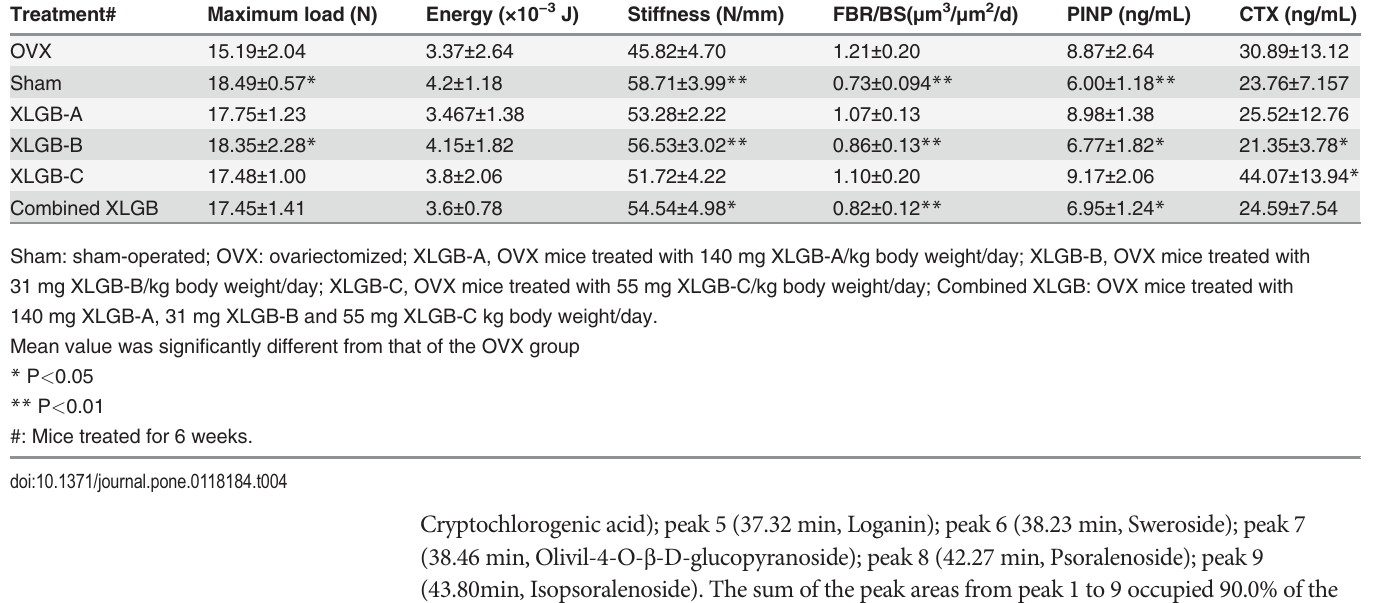
Table 4. Effects of XLGB fractions on biomechanical properties, bone apposition rate and bone turnover marker in OVX mice (mean values ± standard deviations, n = 10). Treatment#